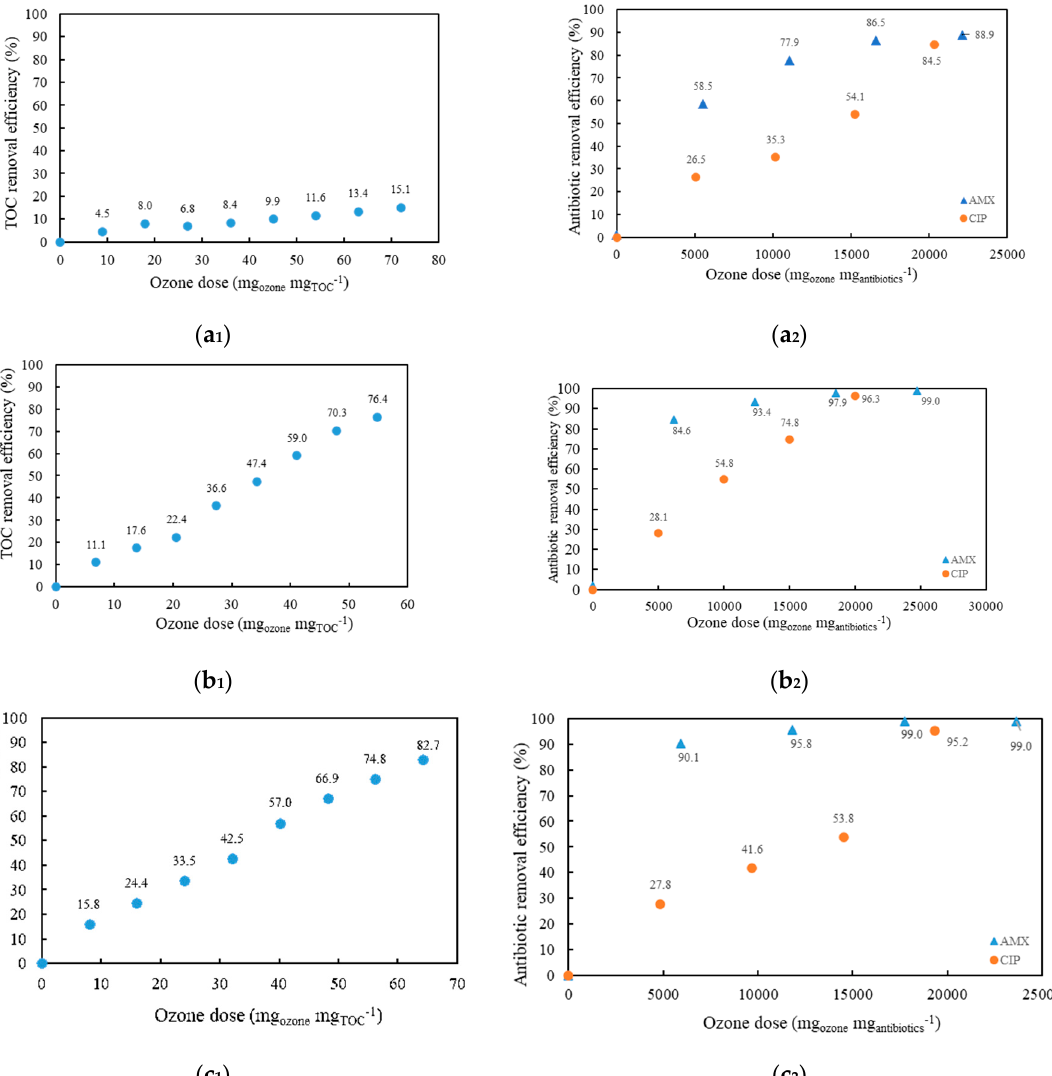
Figure 2. TOC concentration of model wastewater ( a 1 ) and AMX/CIP concentration at pH = 3.70 ( a 2 ). TOC concentration of model wastewater ( b 1 ) and AMX/CIP concentration at pH = 10.85 ( b 2 ). TOC concentration of model wastewater ( c 1 ) and AMX/CIP concentration at pH = 10.85 with addition of H 2 O 2 ( c 2 ).